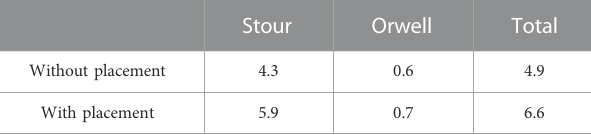
TABLE 5 Predicted annual changes in intertidal area above Chart Datum in the Stour and Orwell Estuary (ha/year).